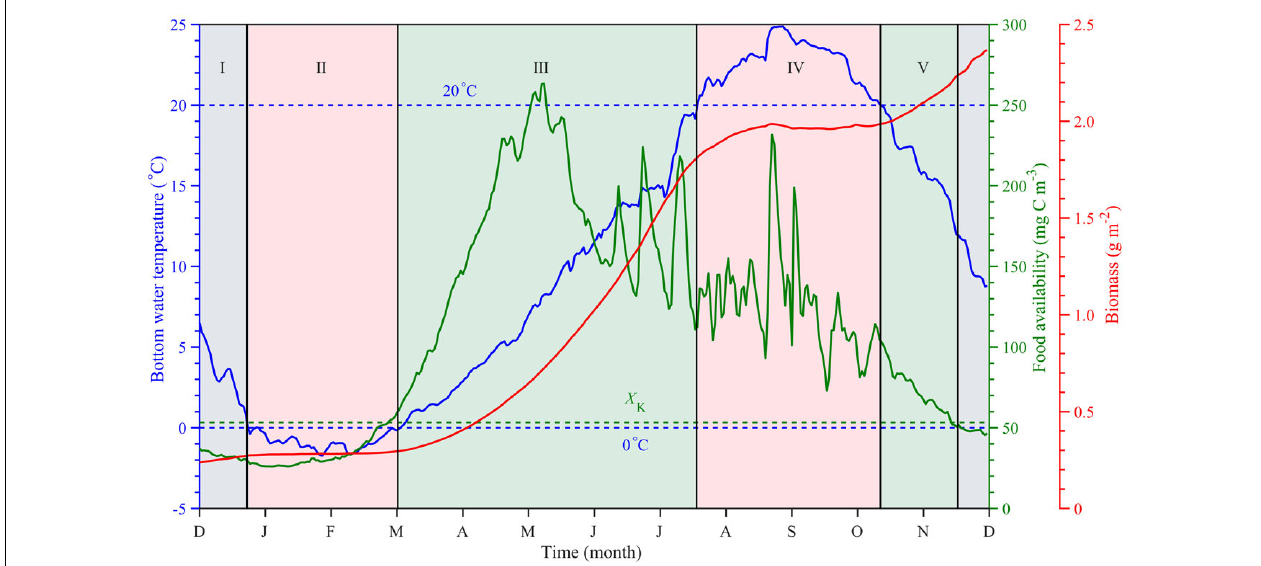
FIGURE 2 | Typical growth stages and match-mismatch conditions between bottom-water temperature and food availability of the Yesso scallops ( Patinopecten yessoensis ) in the Changhai sea area, China. Time series of multiyear average bottom-water temperature (blue solid line), food availability (green solid line), and simulated biomass (red solid line), with auxiliary blue lines of 0 and 20 ◦ C and half-saturation constant X K (green dotted line), also shown. The growth process of scallops can be divided into five stages expressed in Roman numerals. Stage I: The growth of the scallops was mainly limited by the food availability; Stage II: Low temperature and insufficient food led to the stagnation of the scallop growth; Stage III: suitable for scallop growth; Stage IV: The growth of the scallops was mainly limited by high temperature; Stage V: Suitable for growth, but food availability was lower than that in stage III.